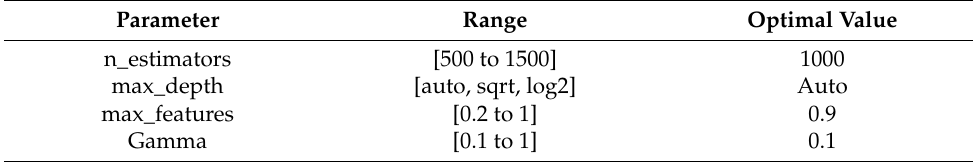
Table A4. Hyperparameter tuned for the XGBoost classifier.